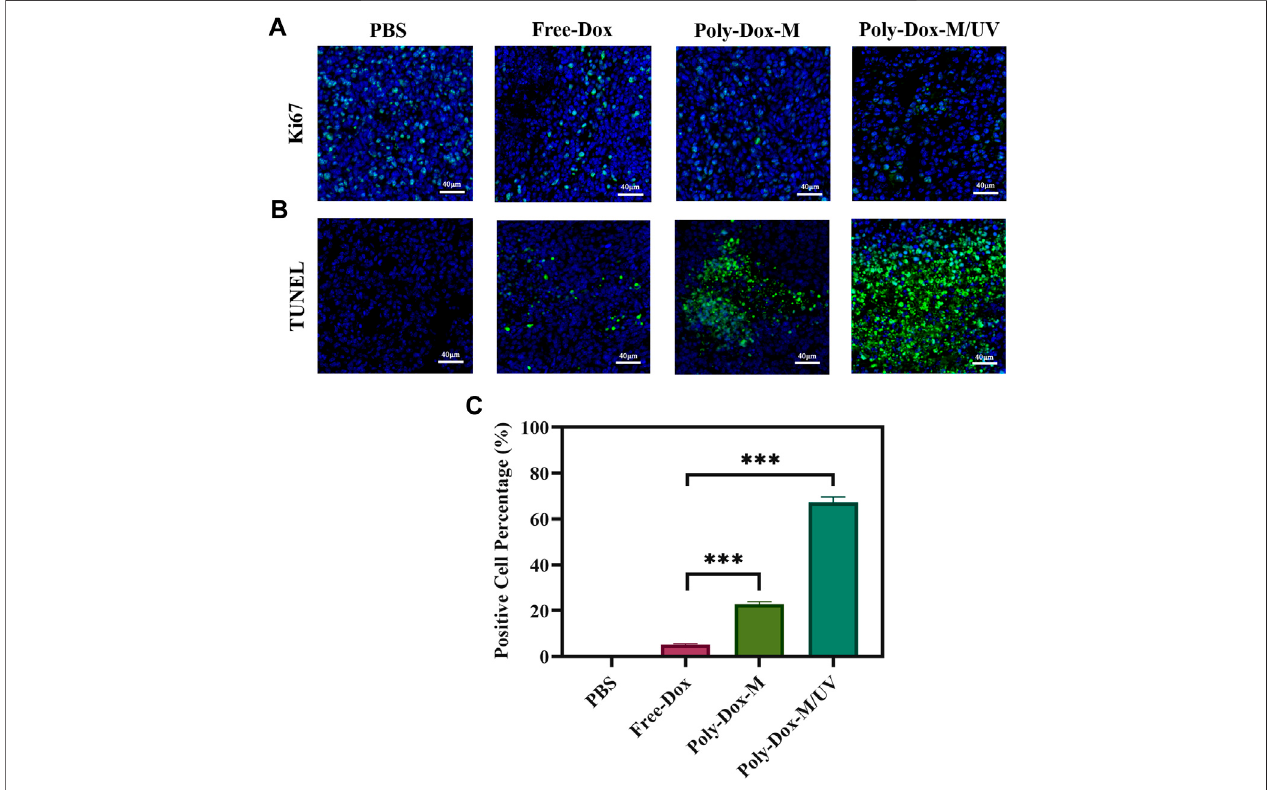
FIGURE 5 | Immuno fl uorescent staining of tumor sections extracted from the mice treated with different samples. (A) Images of immuno fl uorescent staining for Ki67. Blue signals represent nucleus, green signals represent ki67 expression. (B) Images of Tunel staining. Blue signals represent nucleus, green signals represent apoptotic cells. (C) ImageJ analysis of TUNEL positive cell percentage. (Student ’ s t -test, * p < 0.05, ** p < 0.01, *** p <